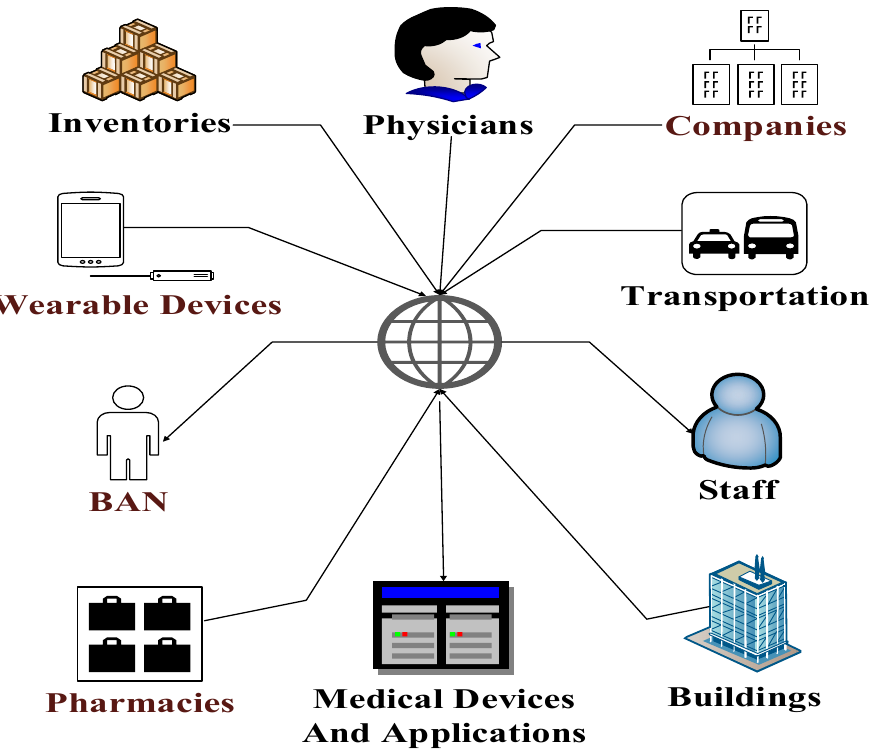
Figure 1. Overall view of IoT e-health system model.